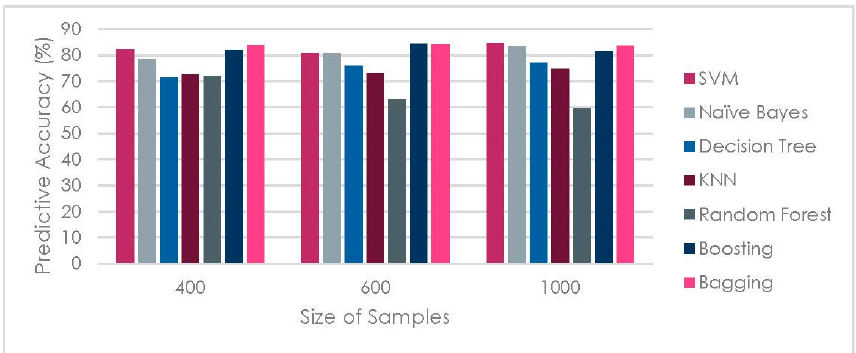
Figure 7. Impact of Sample size on classification model accuracy.